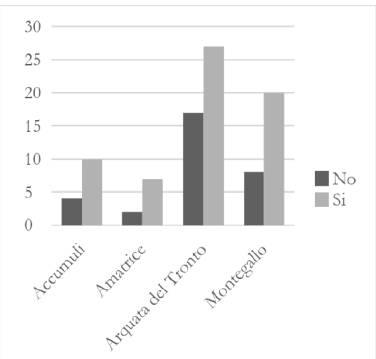
Figure 11. Relation between cantonali and suvey’s location.